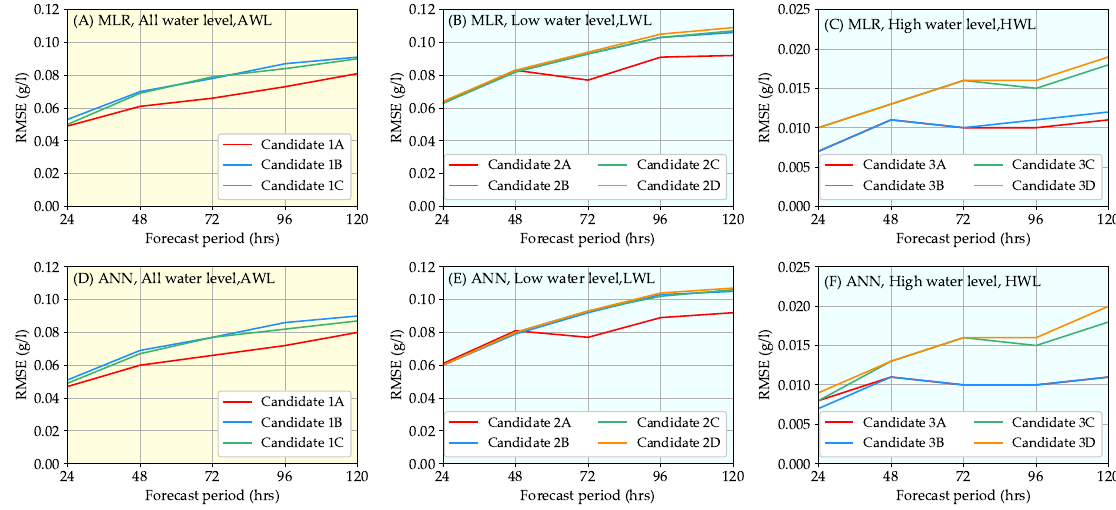
Figure 6. RMSE results of the validation period. Results from the single model, with case AWL, are in the first column with a yellow background ( A , D ). Results from the combined models, with case LWL and case HWL, are in the second and third columns with blue background ( B , C , E , F